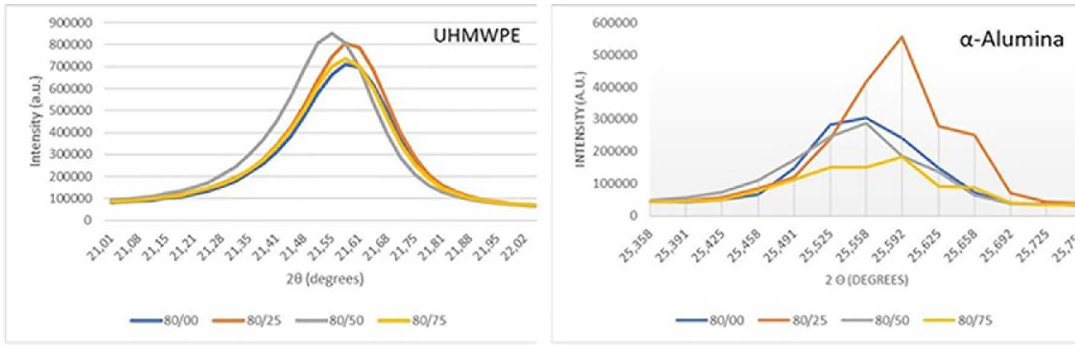
Figure 5. Selected XRD lines of UHMWPE and α-alumina.